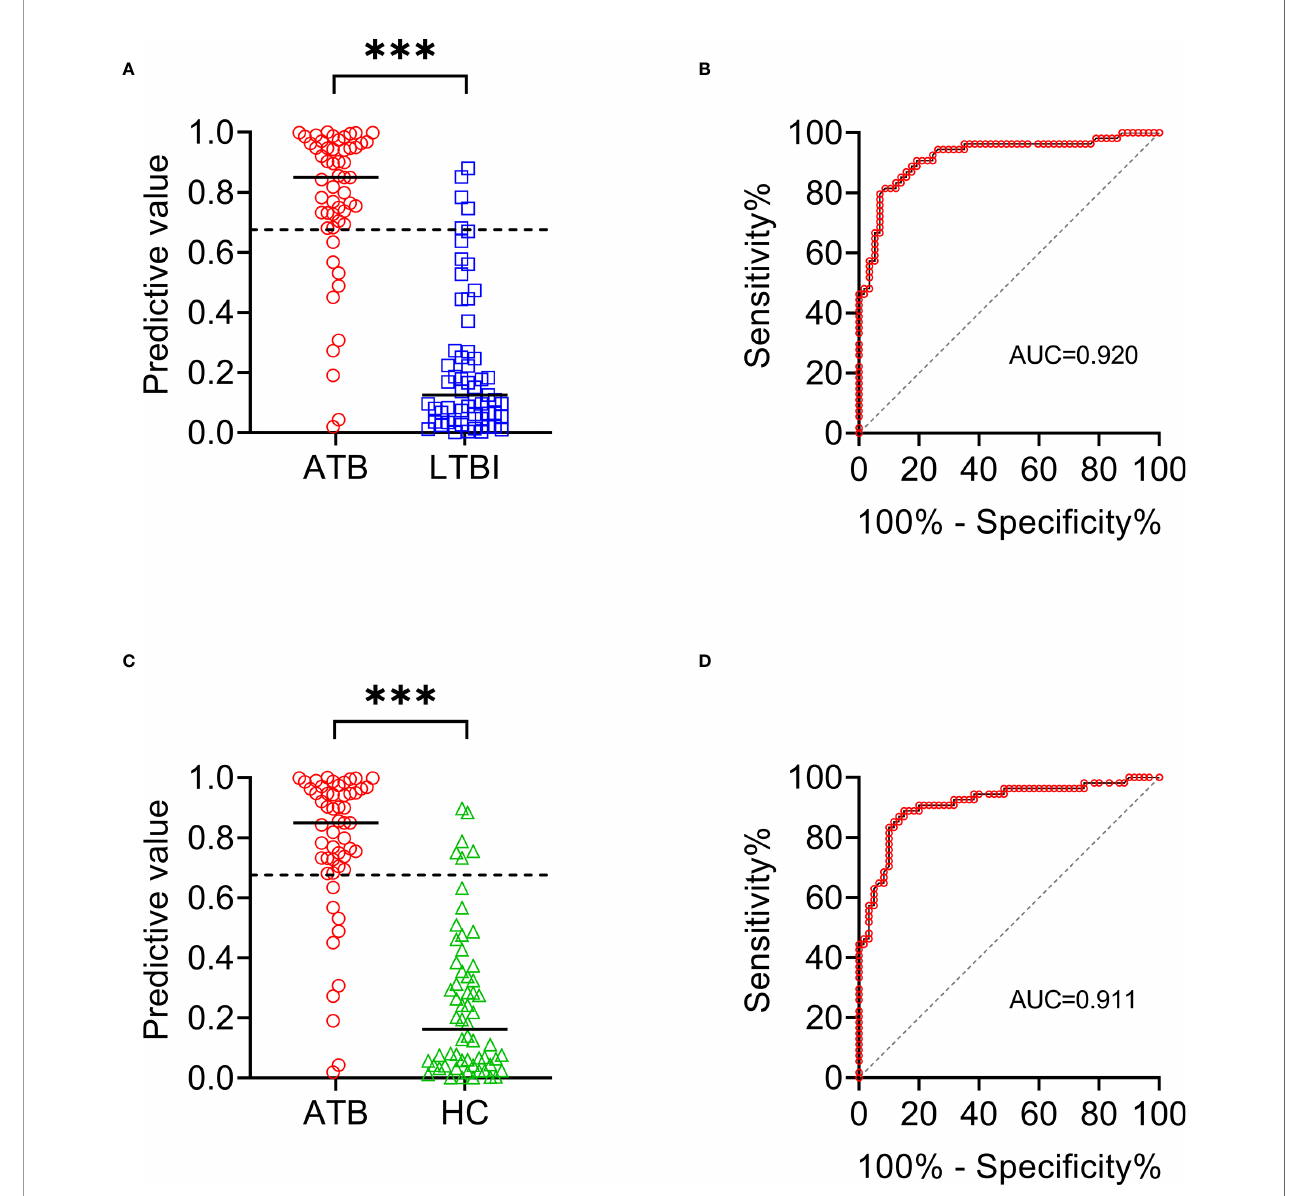
FIGURE 7 | The performance of established diagnostic model for distinguishing ATB from LTBI and HC. (A) Scatter plots showing the predictive value of diagnostic model in ATB patients (n = 54) and LTBI individuals (n = 57). Horizontal lines indicate the median. *** P < 0.001 (Mann-Whitney U test). Dotted line indicates the cutoff value in distinguishing these two groups. (B) ROC analysis showing the performance of diagnostic model in discriminating ATB patients from LTBI individuals. (C) Scatter plots showing the predictive value of diagnostic model in ATB patients (n = 54) and HC (n = 60). Horizontal lines indicate the median. *** P < 0.001 (Mann-Whitney U test). Dotted line indicates the cutoff value in distinguishing these two groups. (D) ROC analysis showing the performance of diagnostic model in discriminating ATB patients from HC. ATB, active tuberculosis; LTBI, latent tuberculosis infection; HC, healthy controls; ROC, receiver operating